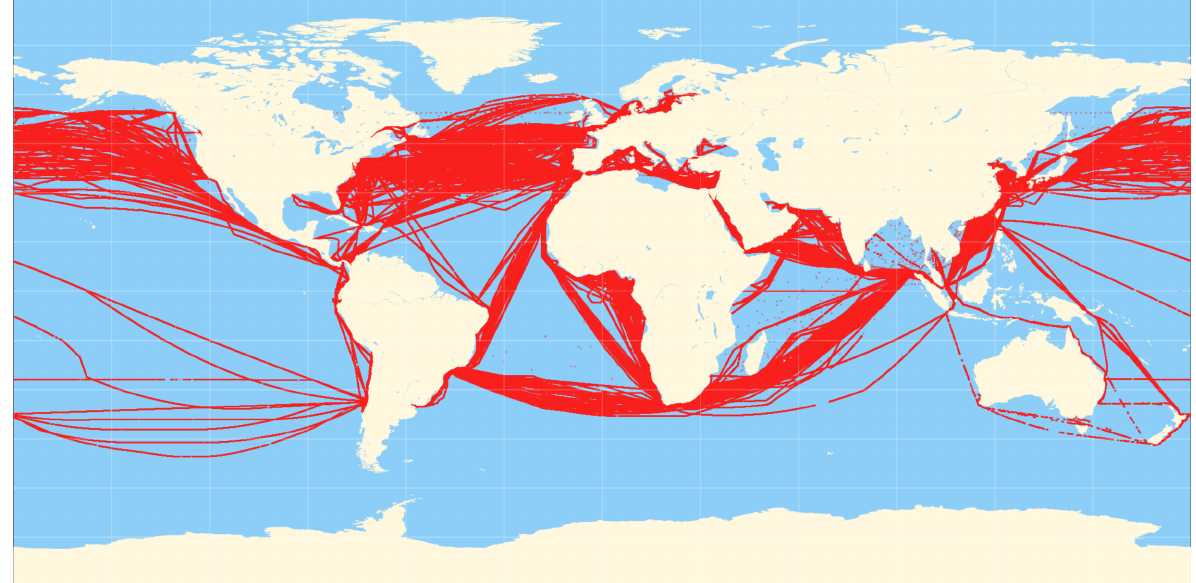
Figure 2. Visualization of N lat and E lon coordinate pairs from all ships included in the main dataset for 3 years of